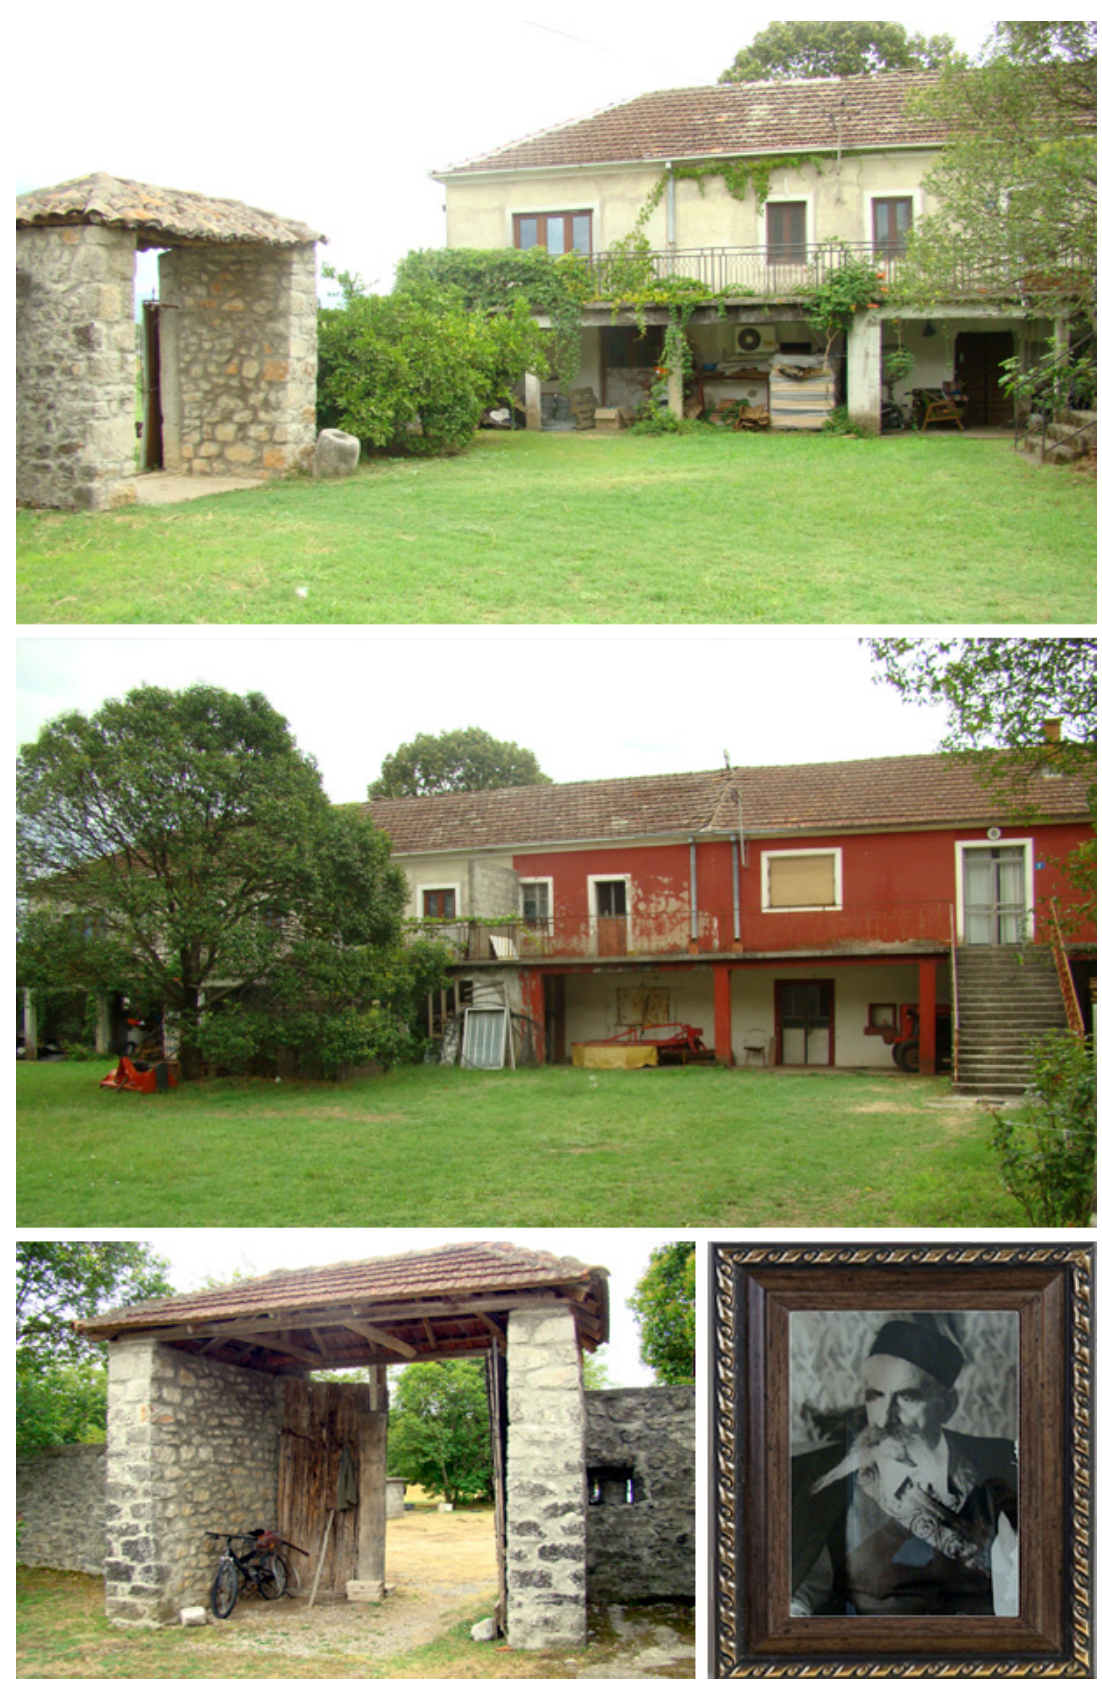
Figure 16. Photos of the House of Maric, Zeta region, Montenegro (G. Skataric).